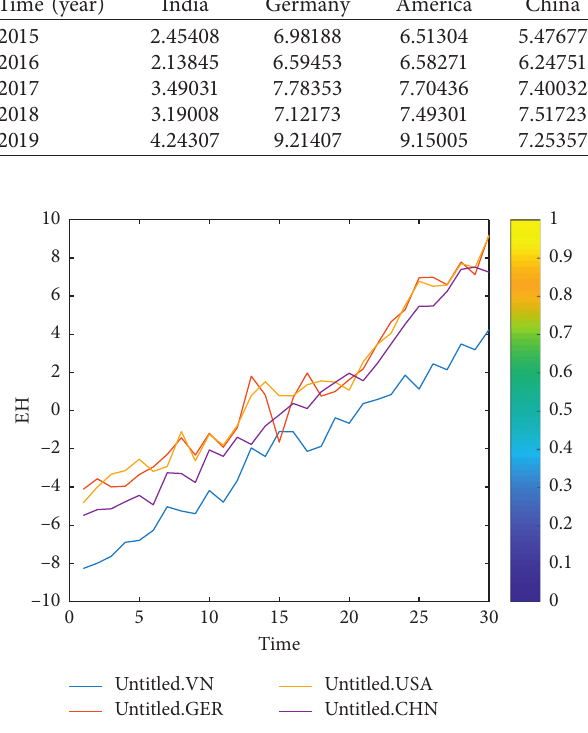
Figure 3: Evaluation of the health status of higher education in four